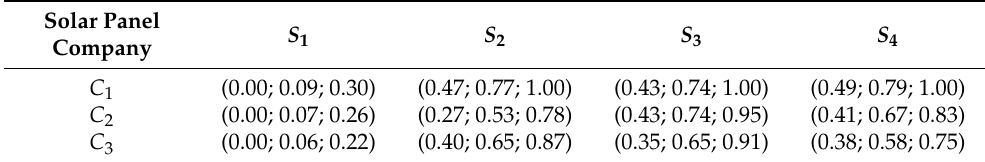
Table 17. Fuzzy weighted normalized decision matrix for M 3 . Solar Panel